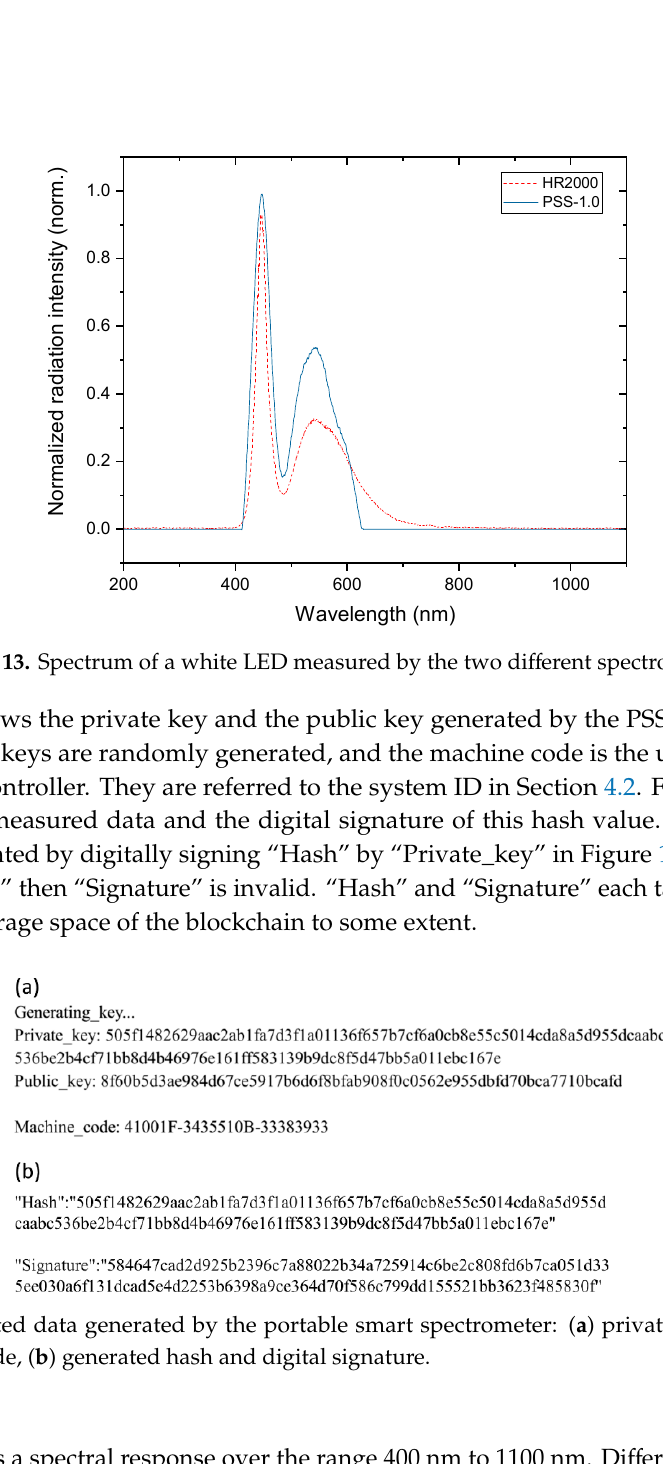
Figure 12. Laboratory portable smart spectrometer.